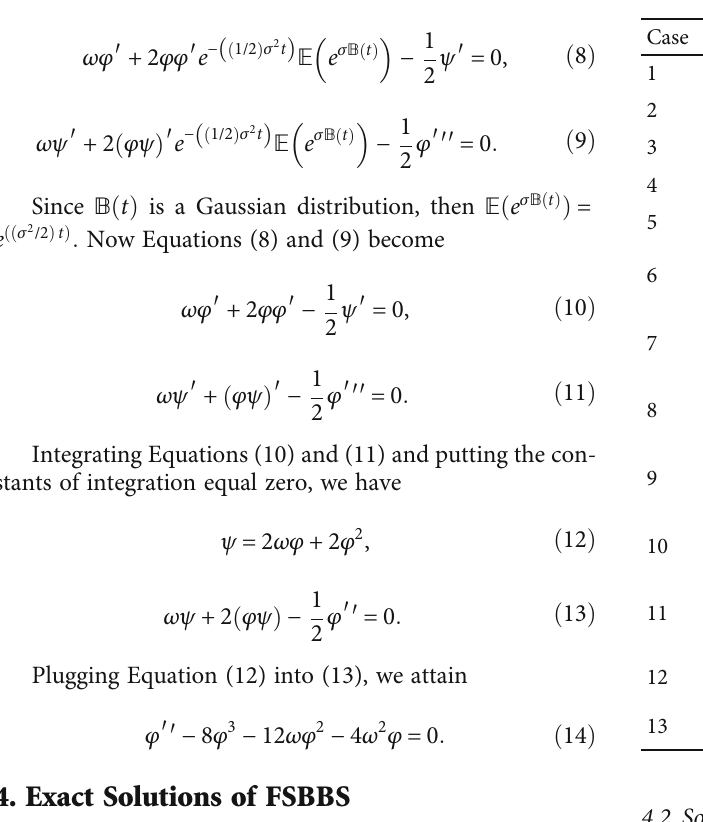
Table 1: All possible solutions for Equation